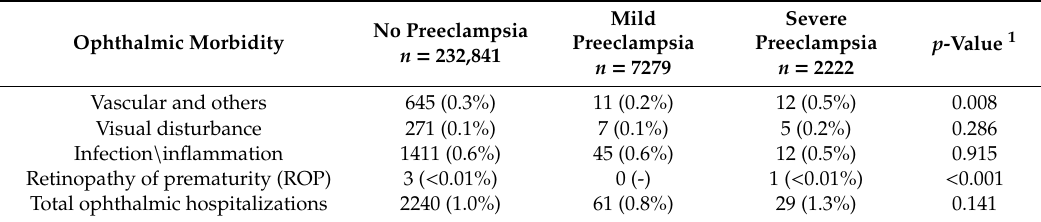
1 Data evaluated using a Pearson chi square test.